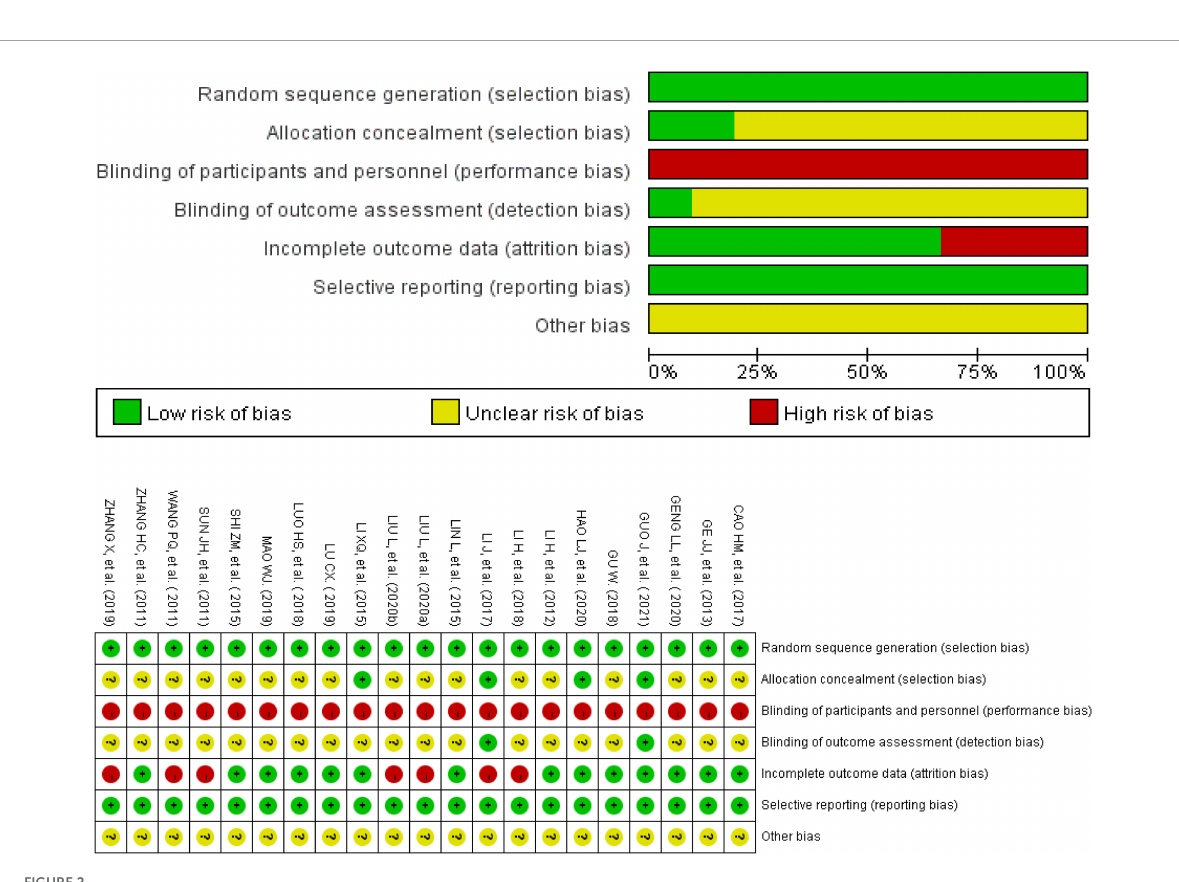
FIGURE2 Risk of bias graph and summary. red, high risk; green, low risk; yellow, unclear risk.